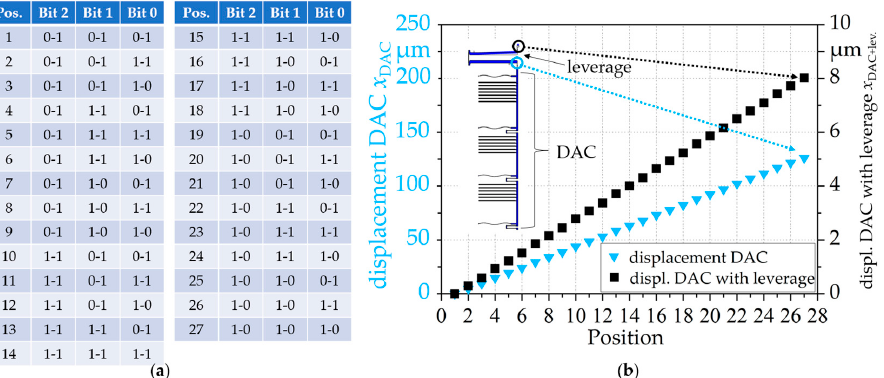
Figure 12. ( a ) Presentation of the 27 positions in logical order addressed by the 3 3 DAC, ( b ) Simulated displacement of a 3-bit DAC with a 3 3 resolution: the DAC performs a binary encoded stepwise displacement that is finally enlarged using a mechanical leverage (an amplification ratio of ~40) to a stepwise and large mechanical displacement. Experimental results are shown in [51–53].